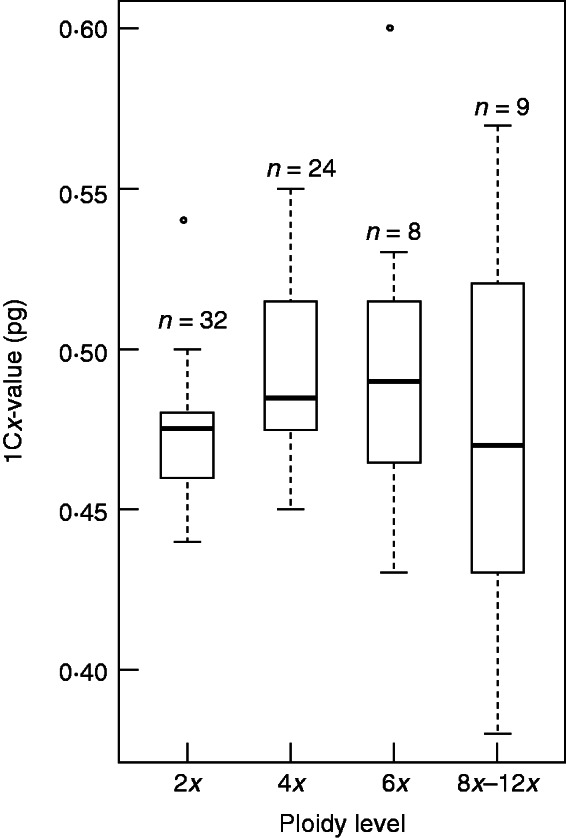
Boxplots showing Betula monoploid (1Cx) genome size of differing ploidy level groups: 2x, 4x, 6x and 8x and above. The number of individuals in each group is shown above the boxplot.